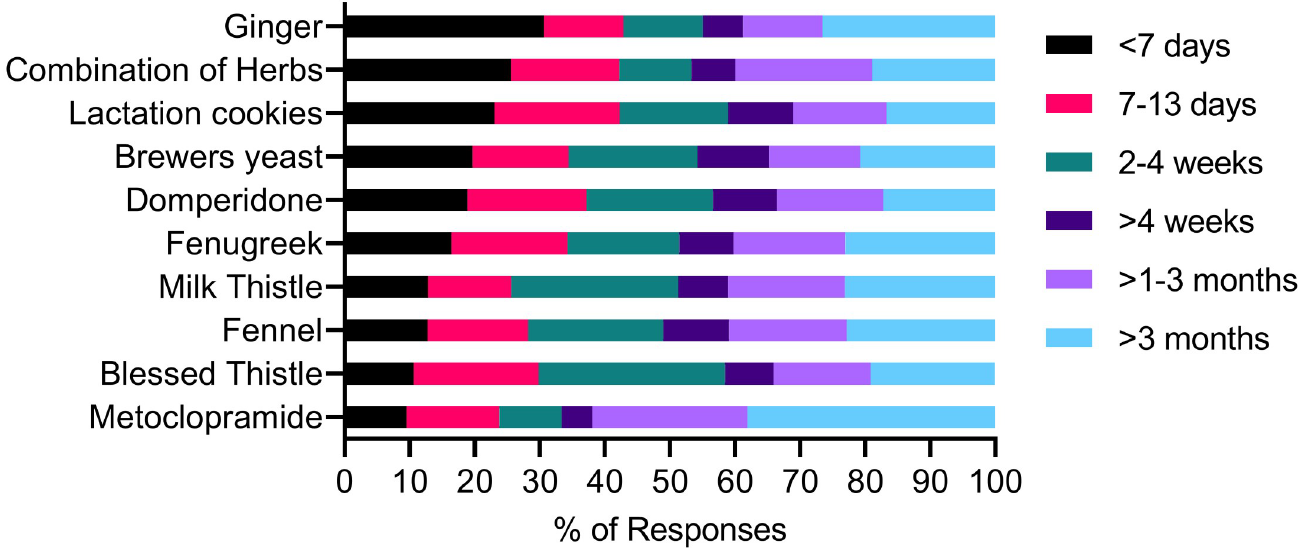
Fig 2. Timing of commencement postpartum of galactagogues during breastfeeding.